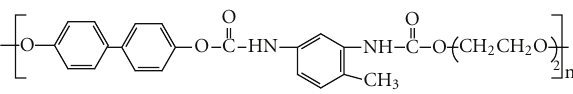
Scheme 1: The molecular structure of LCPU.